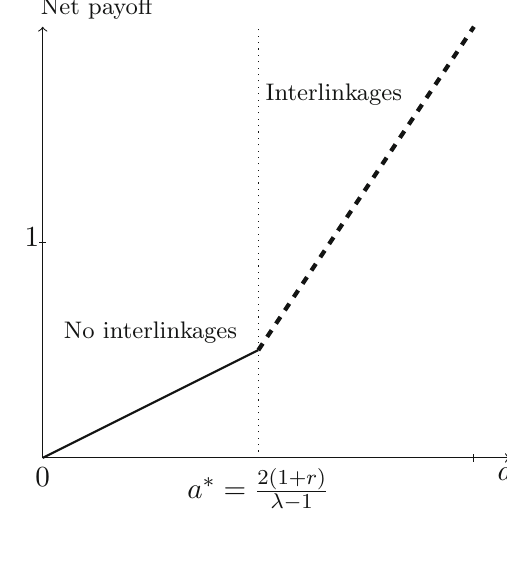
Fig. 2 Ability levels and choice of production (establish interlinkages vs. no interlinkages) with